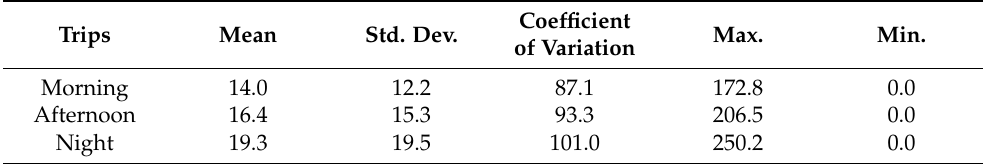
Table 2. Descriptive statistics on the density of origins per hectare and by time